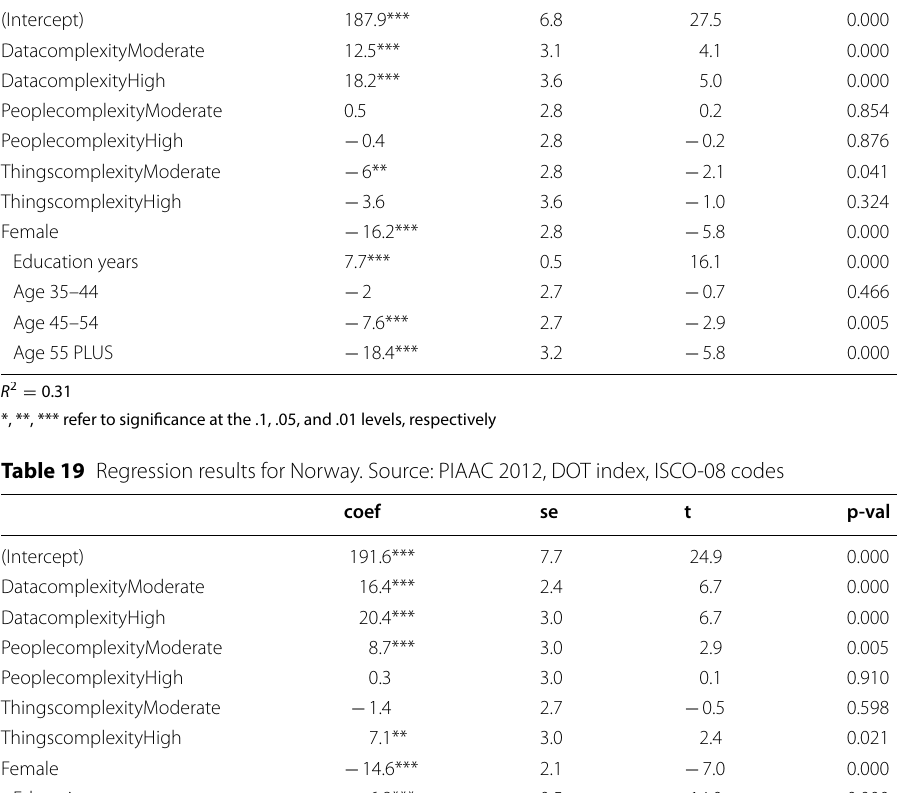
Table 18 Regression results for Netherlands. Source: PIAAC 2012, DOT index, ISCO-08 codes